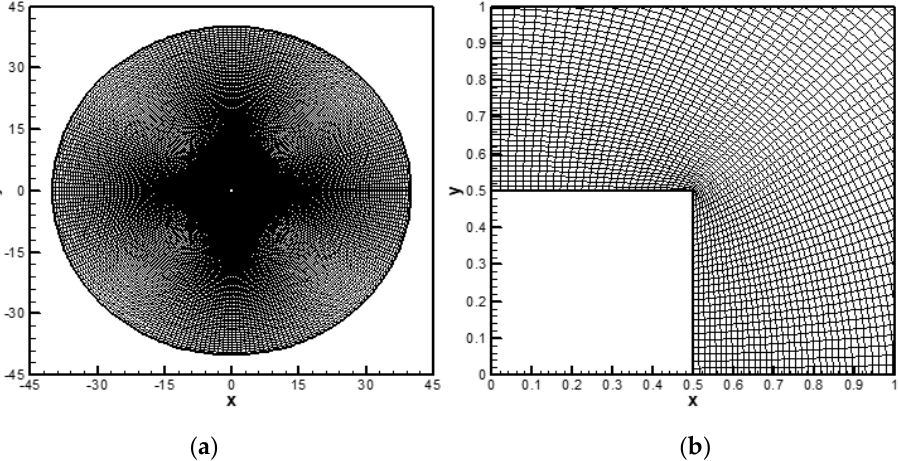
Figure 2. ( a ) Structure of the grid (241 × 258) in the physical (x-y) plane and ( b ) magnified view of the grid near the cylinder surface.